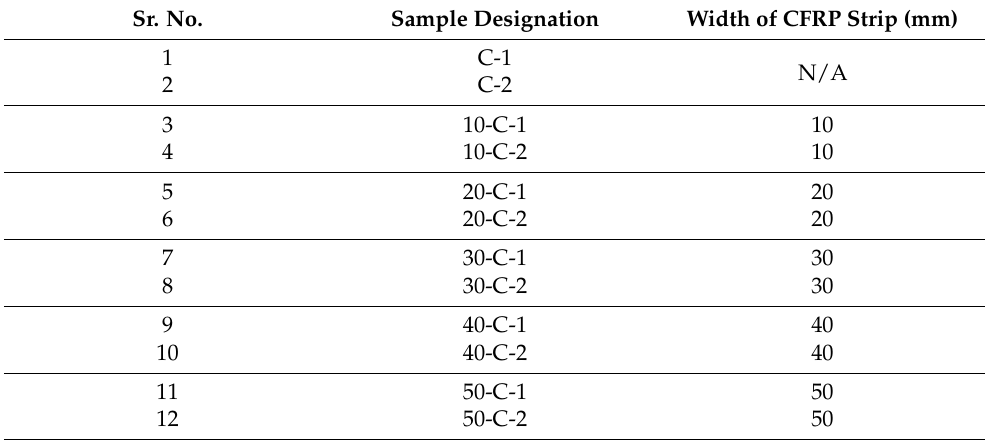
Table 1. Designation of test specimens. Sr.